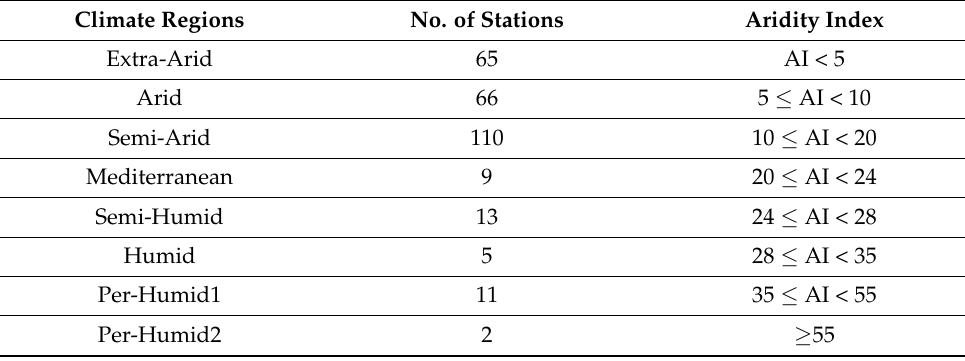
where P denotes Mean Annual Precipitation (MAP) in mm and T is mean annual tempera- ture in Centigrade ( ◦ C). Table A1. Climate zones of the studied stations based on De Martonne method. Climate Regions No. of